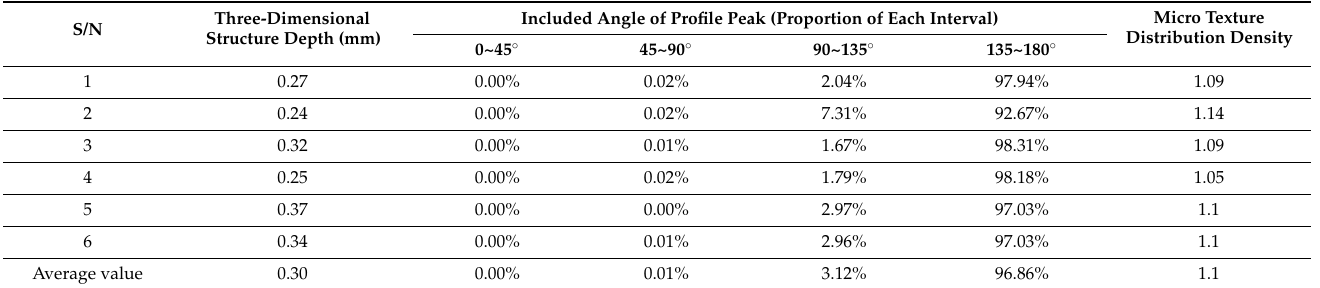
Table 6. Results for EA-10C laser texture detection.